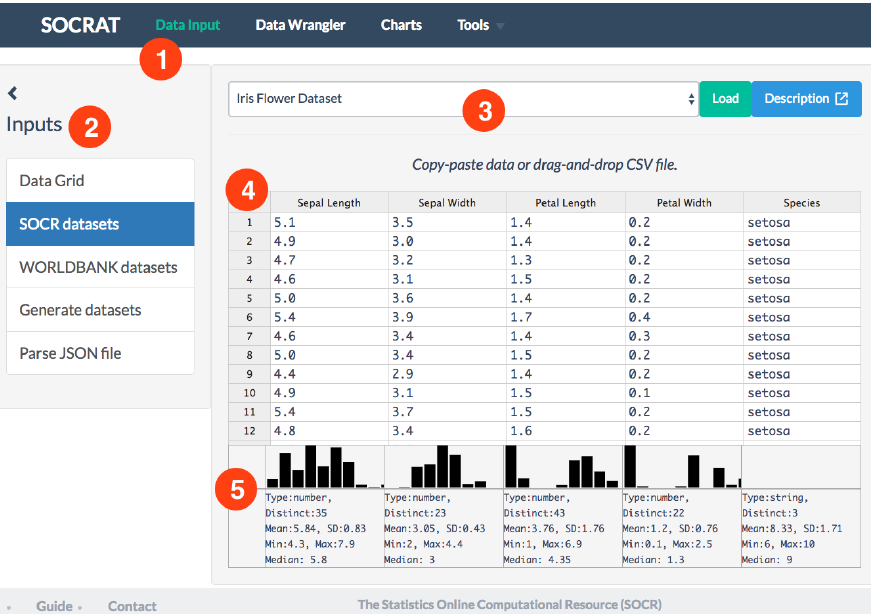
Figure 3. Overview of DataInput module: ( 1 ) user interface includes sidebar with various data sources and central area panels with data view; ( 2 ) data sources include data grid, a number of predefined SOCR datasets, ability to load data from the World Bank using web API; ( 3 ) central panel includes source-specific secondary controls, including links to dataset description; ( 4 ) dynamic, editable spreadsheet-like data grid contains raw data values view and also allows to drag-and-drop CSV/TSV file to load the data; and ( 5 ) summary information panel below the data grid shows histogram and reports summary statistics for for each variable in the famous Iris flower